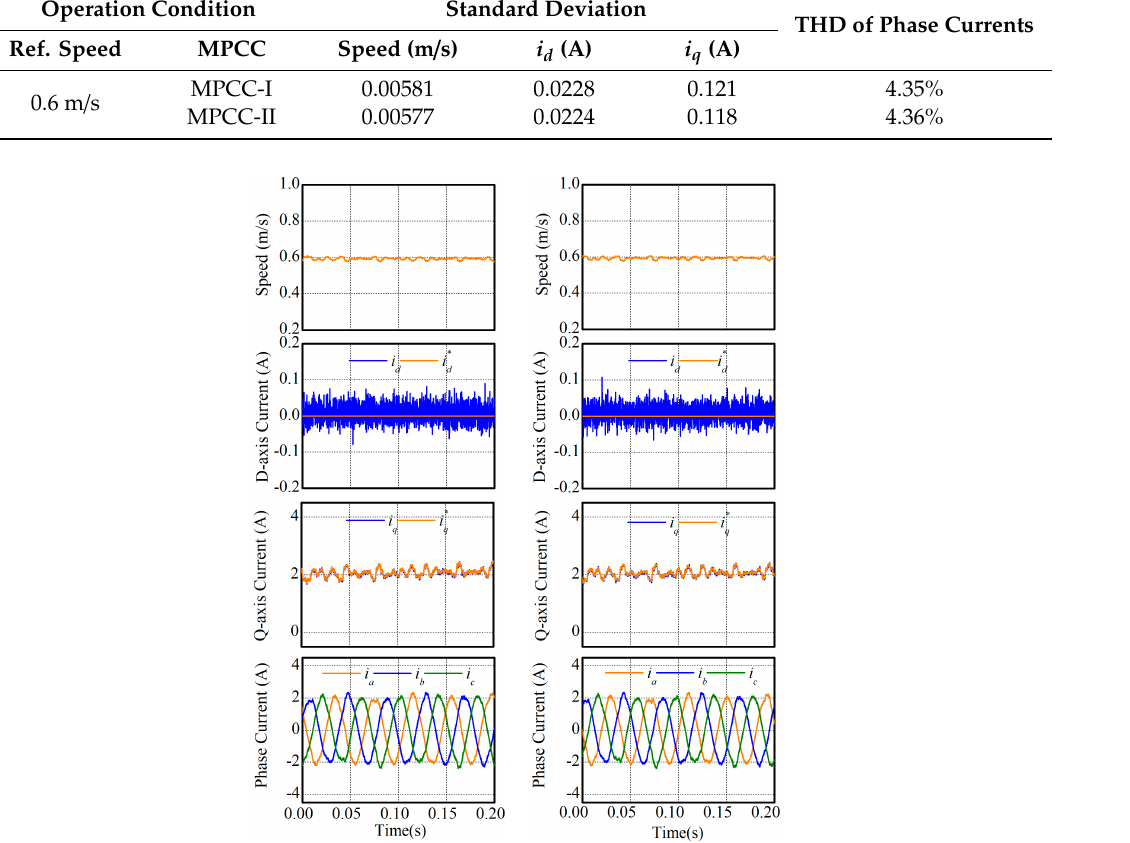
Table 6. Performance comparison with inaccurate mover resistance.